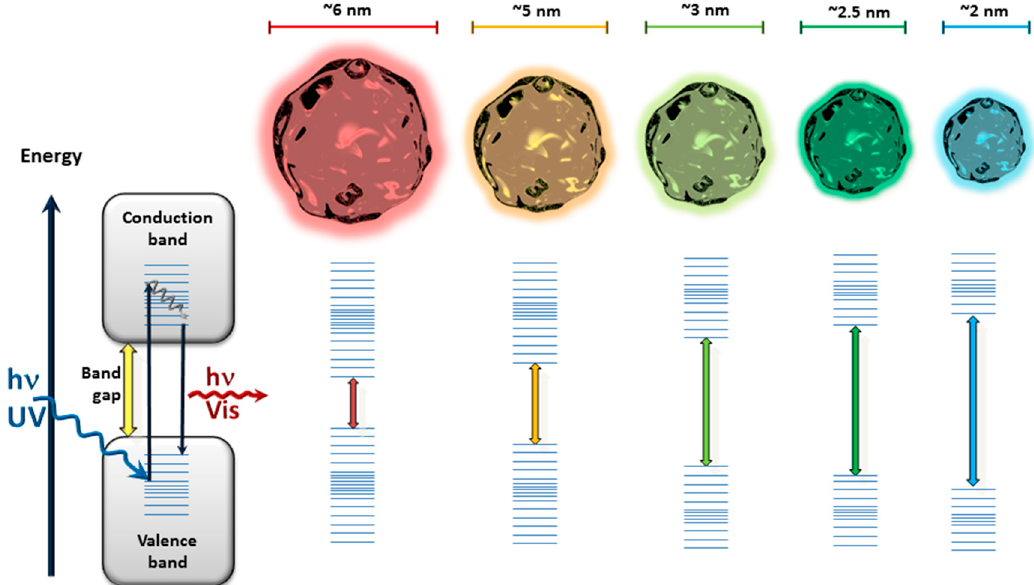
Figure 2. Illustration of QDs with different sizes and the related band gaps leading to different emission wavelengths after excitation with UV